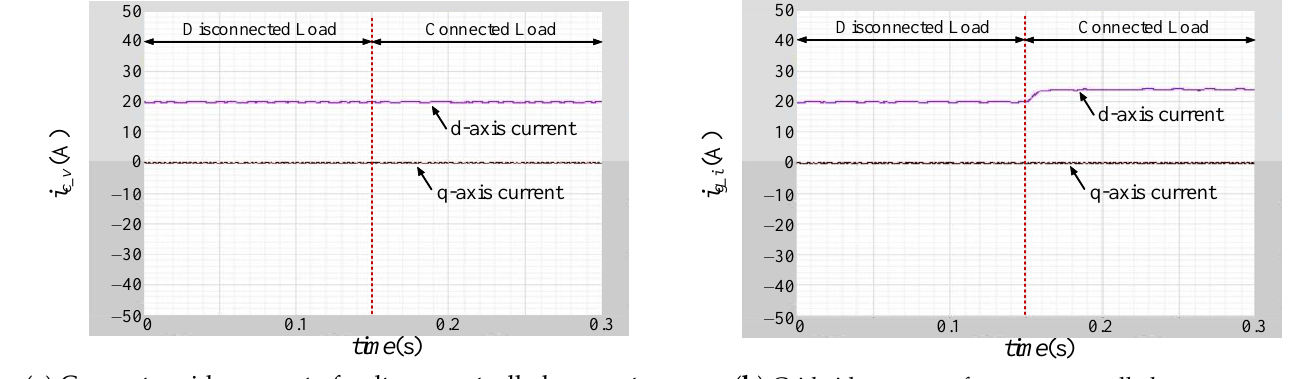
Figure 10. The output current of two converters under master-slave control (load is 150 Ω). ( a ) Converter-side current of voltage-controlled converter; ( b ) Grid-side current of current-controlled converter.